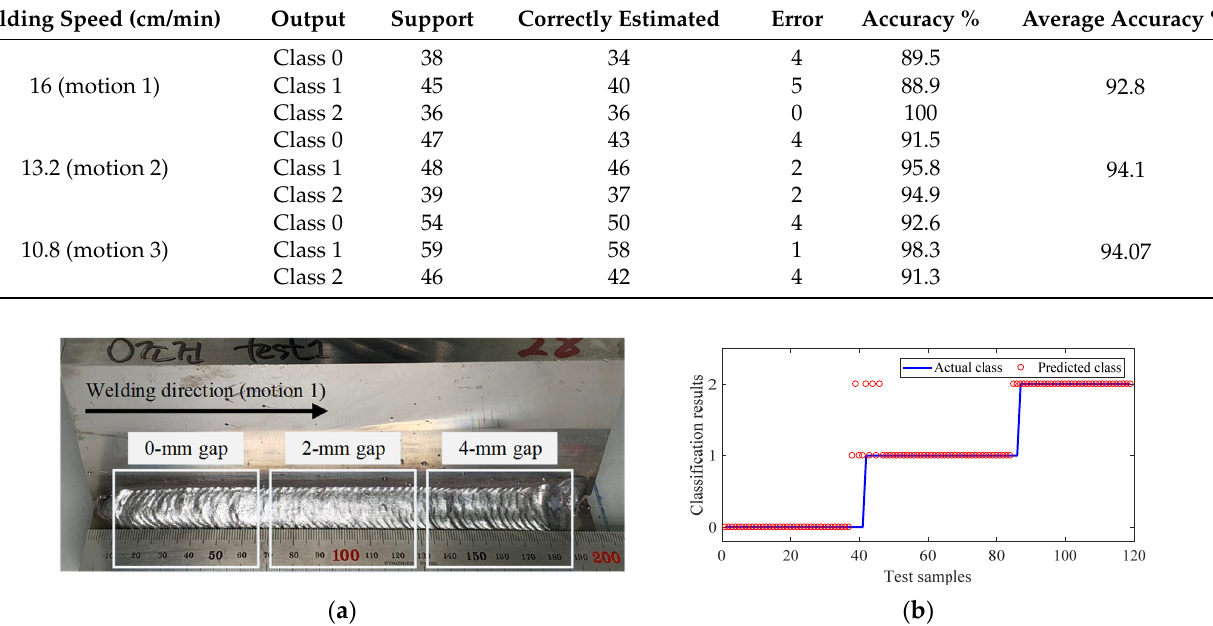
Metals 2021 , 11 , x FOR PEER REVIEW Figure 10. Offline verification results for optimal conditions for 0 mm gap (applied robot motion 1): ( a ) weld bead shape of each weld gap region and ( b ) weld gap classification results.